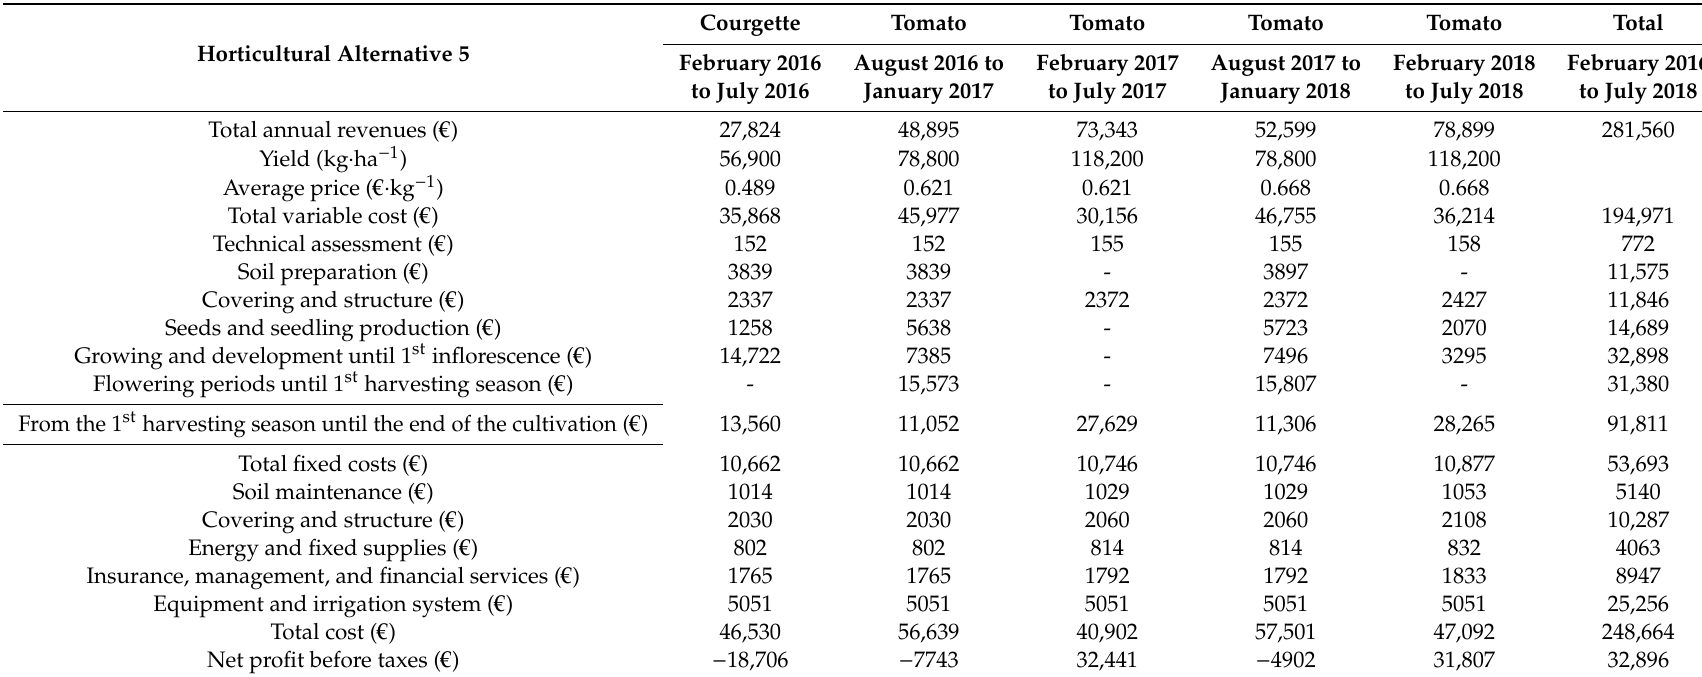
Table A7. Revenues and expenses per hectare imputed to the cultivation of the horticultural alternative 5 in a 30-month cycle (2016–2018). Courgette Tomato Tomato Tomato Tomato Horticultural Alternative 5